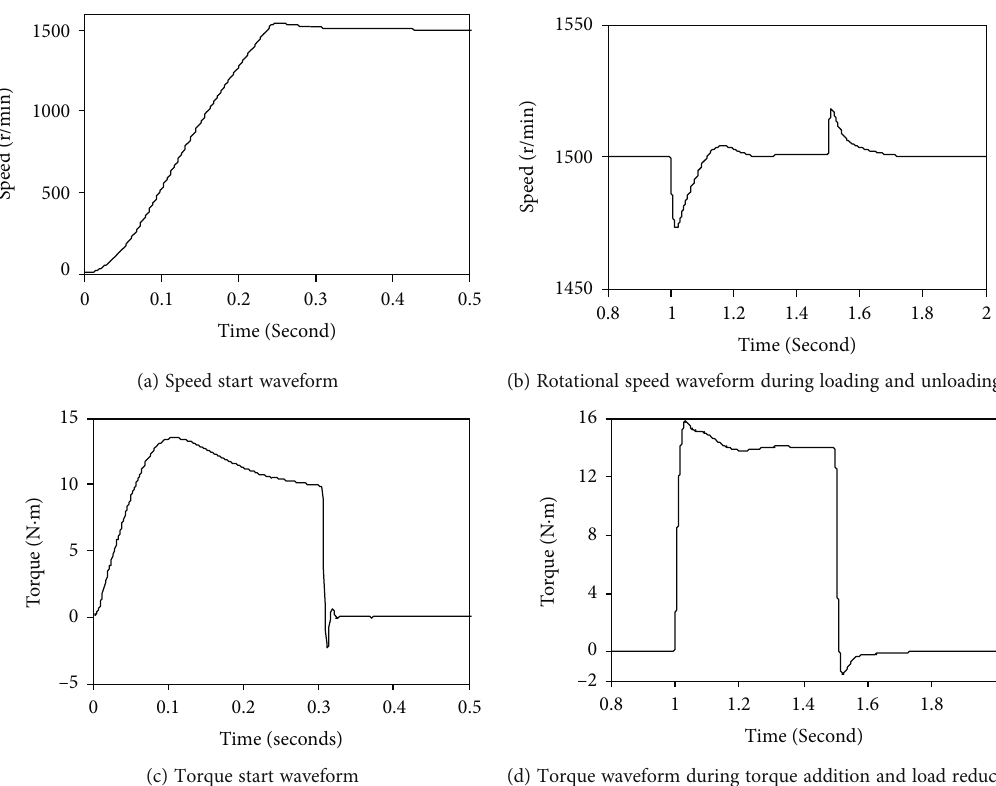
Figure 10: Veri fi cation of correctness of active disturbance rejection